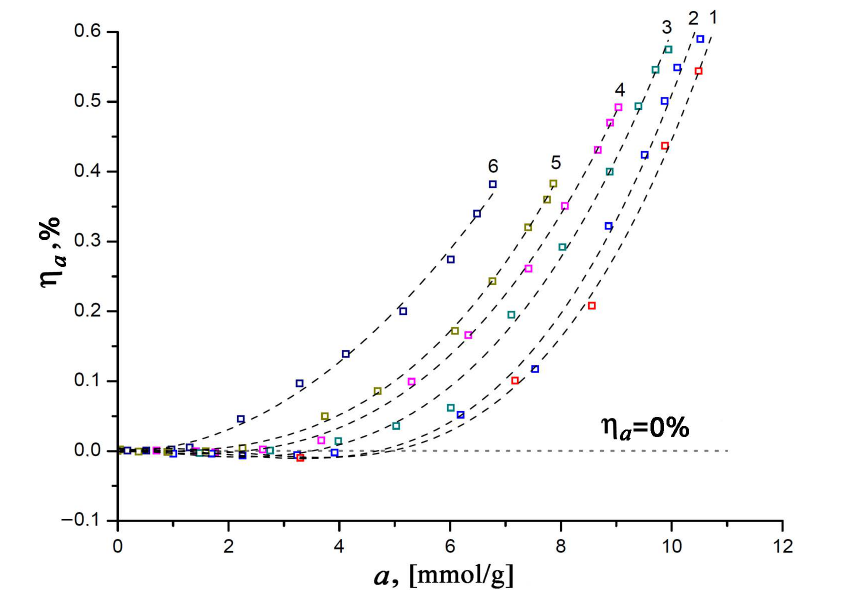
Figure 6. Relative linear deformation of the SiC-AC adsorbent versus Xe adsorption value at temper- atures T , K: 1—216; 2—243; 3—273.15; 4—313; 5—353; and 6—393. Symbols are the experimental data; a dashed straight line indicates a zero variation in the size of the SiC-AC adsorbent; and dashed curves are the spline